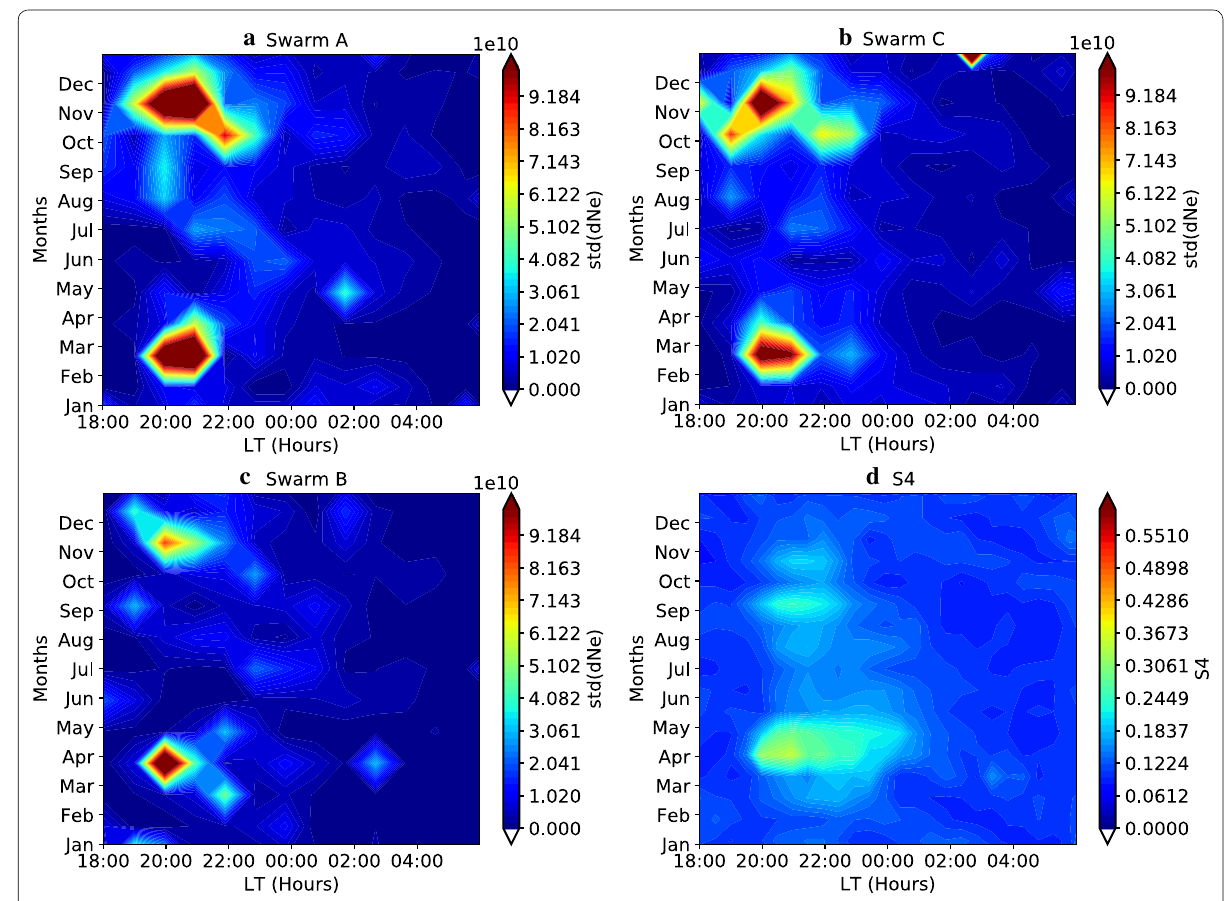
Fig. 7 Month and local time (LT) variations of std( dN e ) (panels ( a – c ) and S 4 index (panel ( d )) for the years from 2014 to 2018